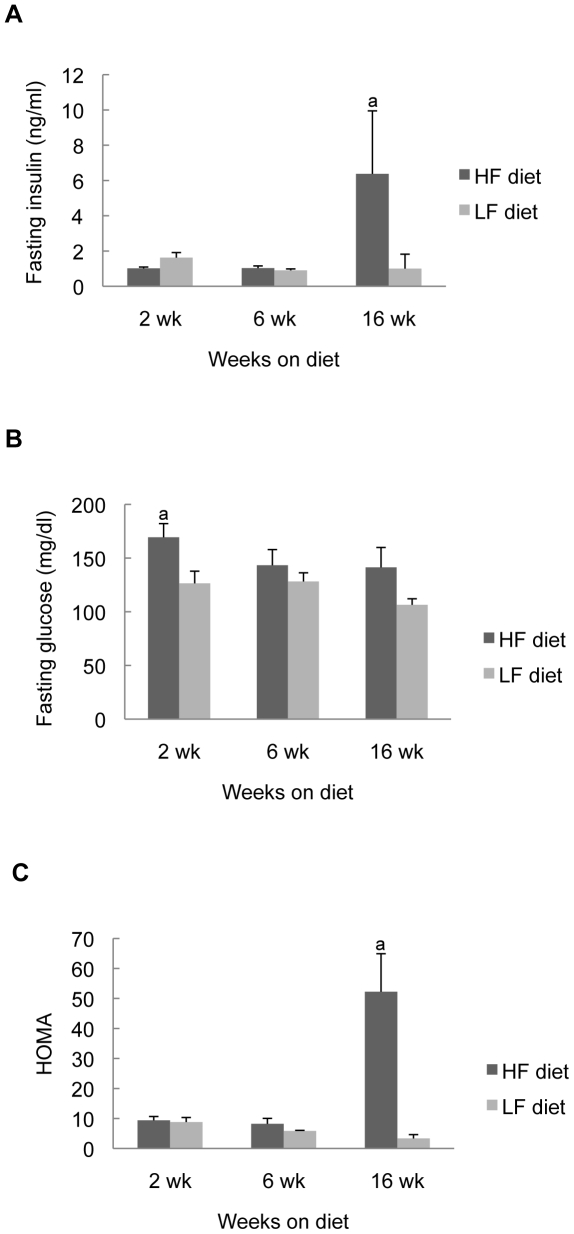
Metabolic measurements in CONV mice fed HF or LF diet.Data are expressed as mean ± SE; Note that food was withdrawn from mice 4 hours before plasma collection for insulin and glucose assays. a: P<0.05 vs LF group.